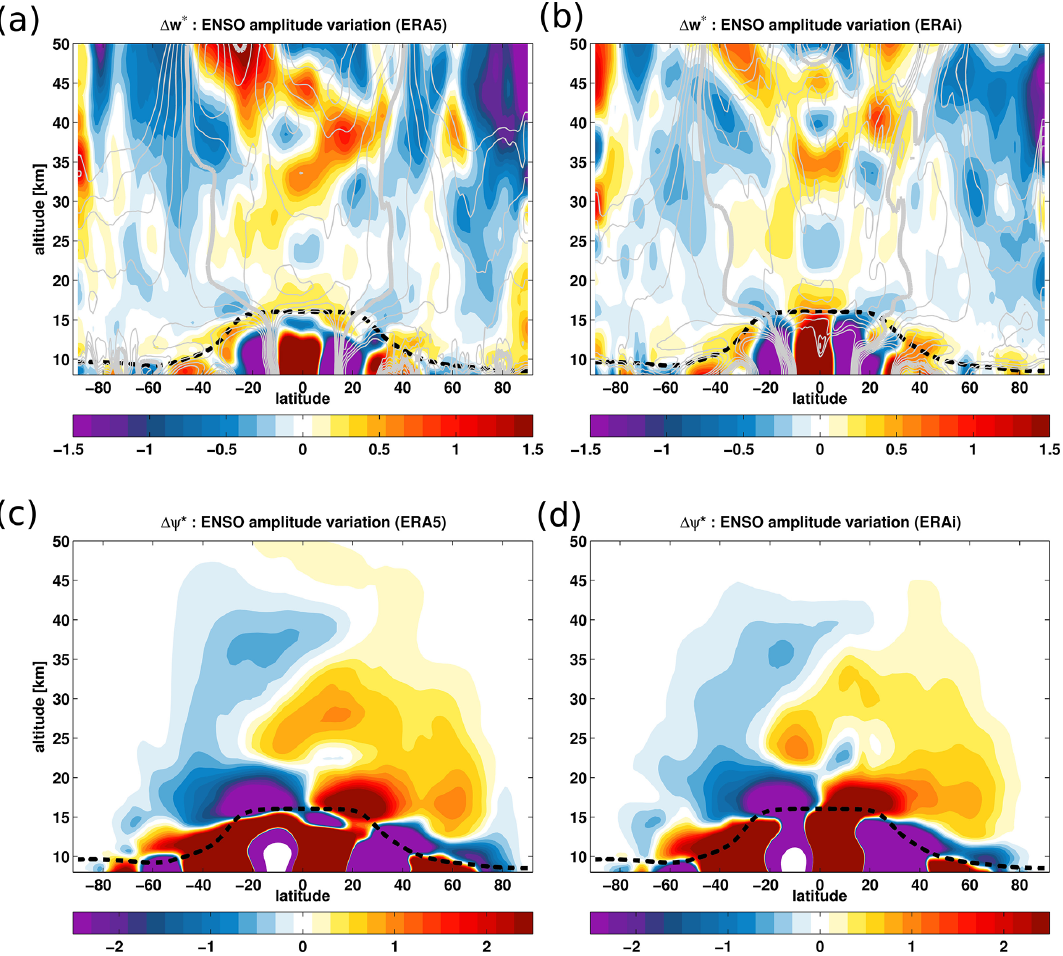
Figure 9. ENSO impact on the residual vertical velocity ( w ∗ ) (a, b) and the residual stream function ( ψ ∗ ) (c, d) from the ERA5 (a, c) and the ERA-Interim (b, d) reanalyses for the 1979–2018 period. The amplitude of the w ∗ and ψ ∗ variations attributed to the ENSO signal are estimated by fitting on the ENSO predictor using the regression model (Eq. 10) and normalized by the standard deviation of the proxy for the 1979–2018 period. Unit: mms − 1 × SD ( proxy ) . The climatological tropopause from the ERA-Interim is indicated as the dashed black horizontal line. Zonal mean climatology of w ∗ is superimposed as dashed grey